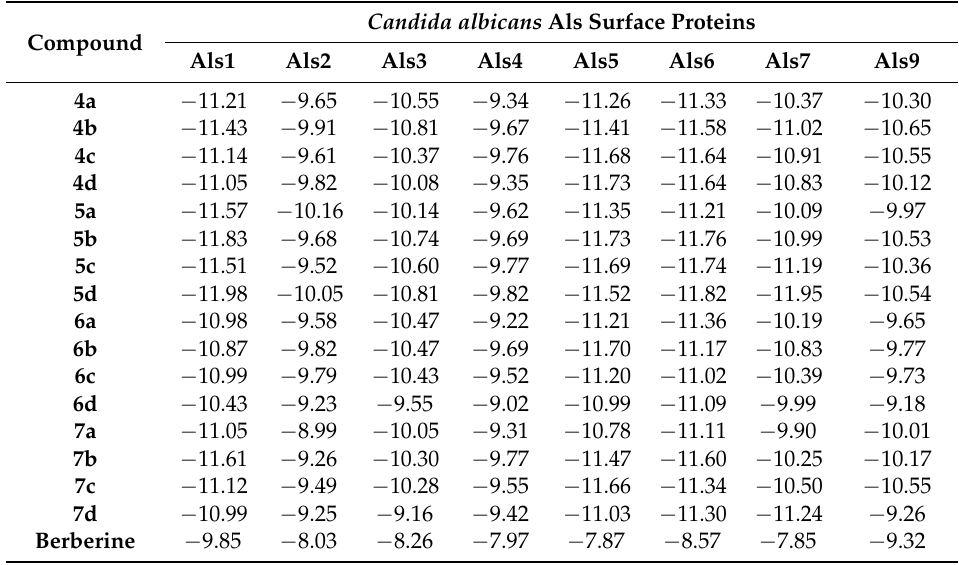
Table 4. Binding energies (kcal/mol) of the tested compounds-Als complexes. Candida albicans Als Surface Compound